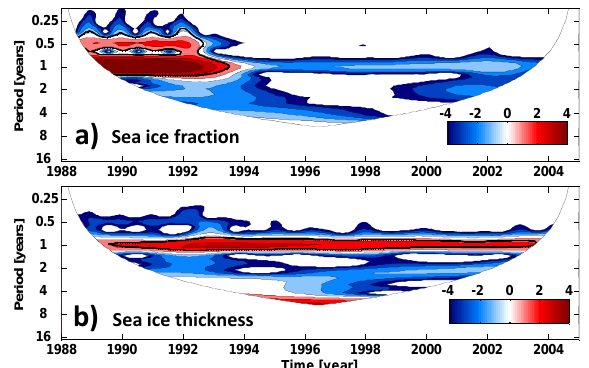
Fig. 12. The wavelet power spectrum of Weddell Sea sector (a) sea ice fraction and (b) sea ice thickness time series using the Morlet wavelet. The white area is the cone of influence, where zero padding has reduced the variance. The black thick contour encloses regions where confidence levels were greater than 90% for a red-noise pro- cess with a lag-1 coefficient of 0.72. The units (colourbar) are the energy in log 2